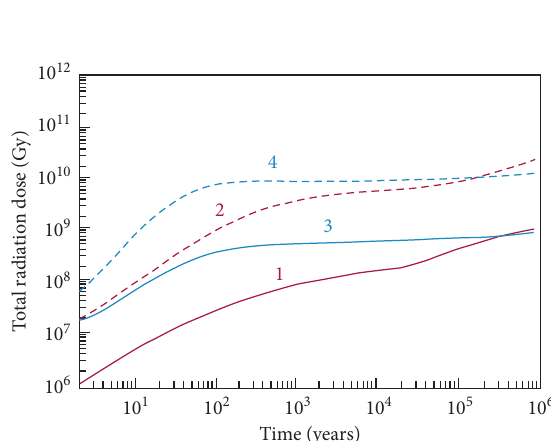
Figure 1: Absorbed dose (Gy) of HLW according to [17]. 1, α -radiation of defense HLW; 2, α -radiation of commercial HLW; 3, β -radiation of defense HLW; 4, β -radiation in commercial